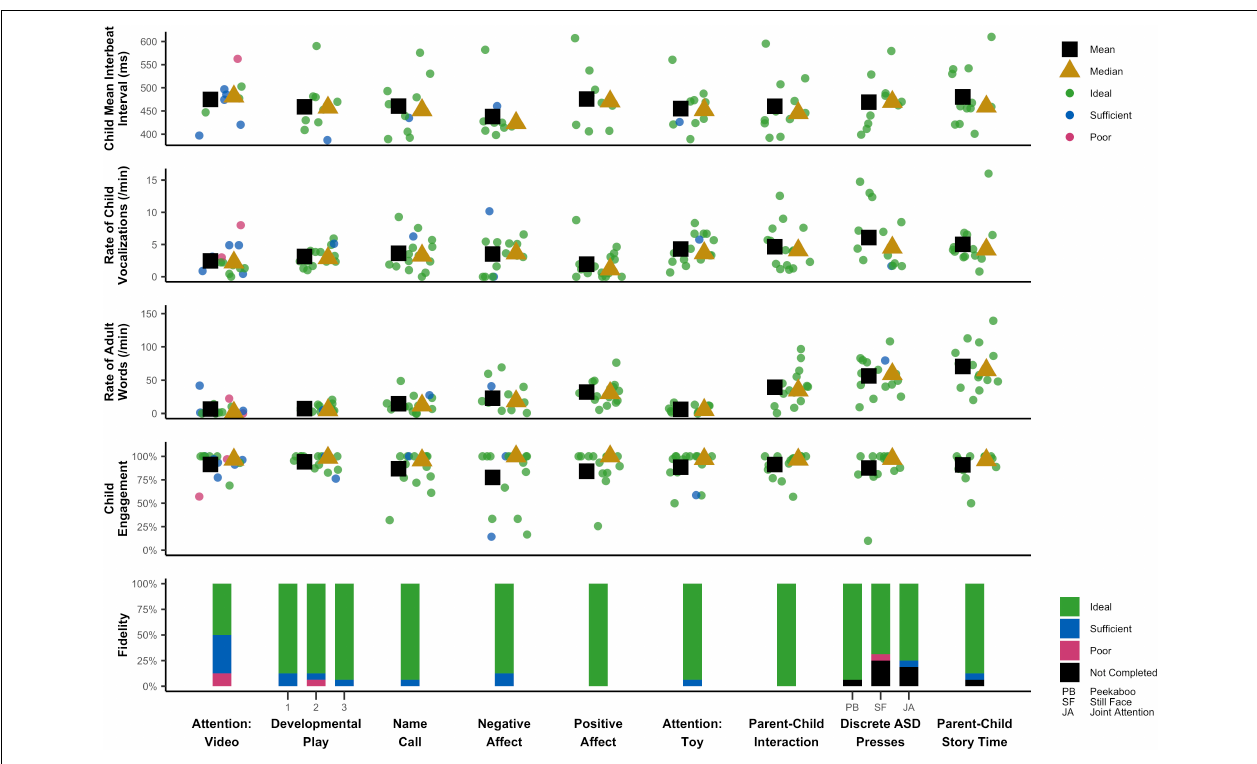
FIGURE 1 | Sample clinical, behavioral, and spectral outcome variables across PANDABox